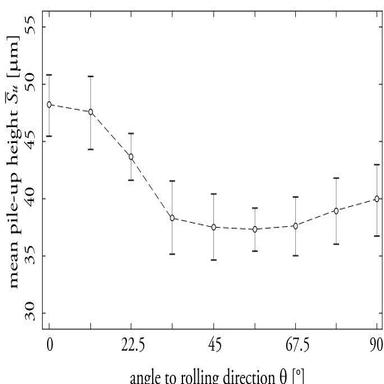
The mean pile-up height Su in relation to the angle from rolling direction θ. The bars show the standard deviation std(Su) of a population.